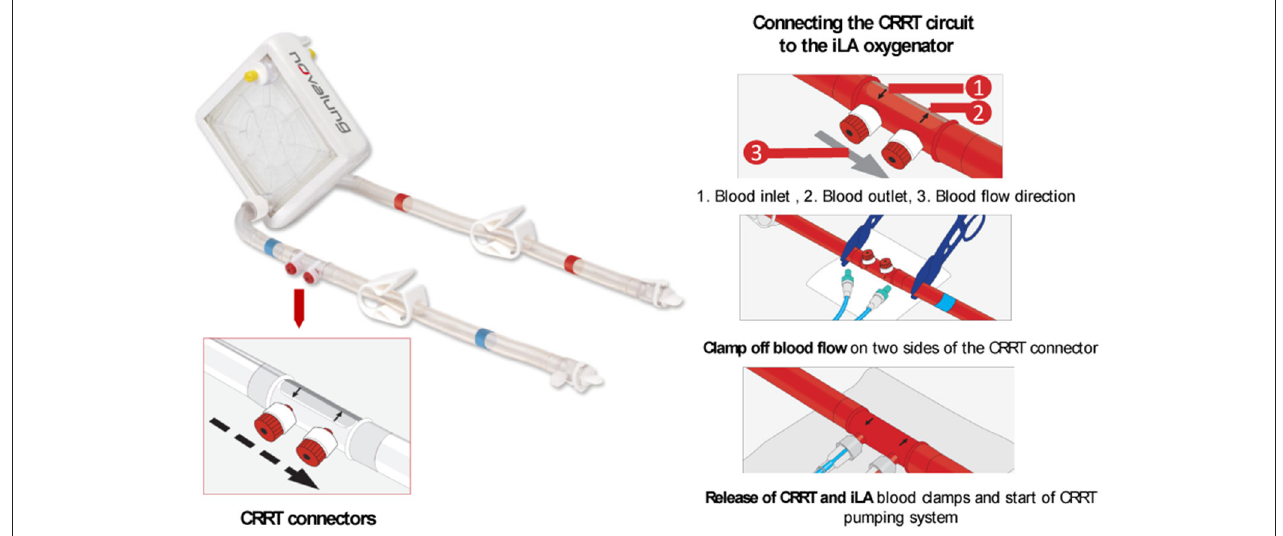
FIGURE 8 | The iLA oxygenator (Xenios) offers CRRT connectors for simultaneous lungs and extracorporeal renal replacement therapy without the need of additional vascular access. The CRRT circuit is connected to the iLA system by the use of a inlet and outlet CRRT connector with the assistance of blood clamps. Modified from the ILA membrane ventilator (Xenios) procedure description (